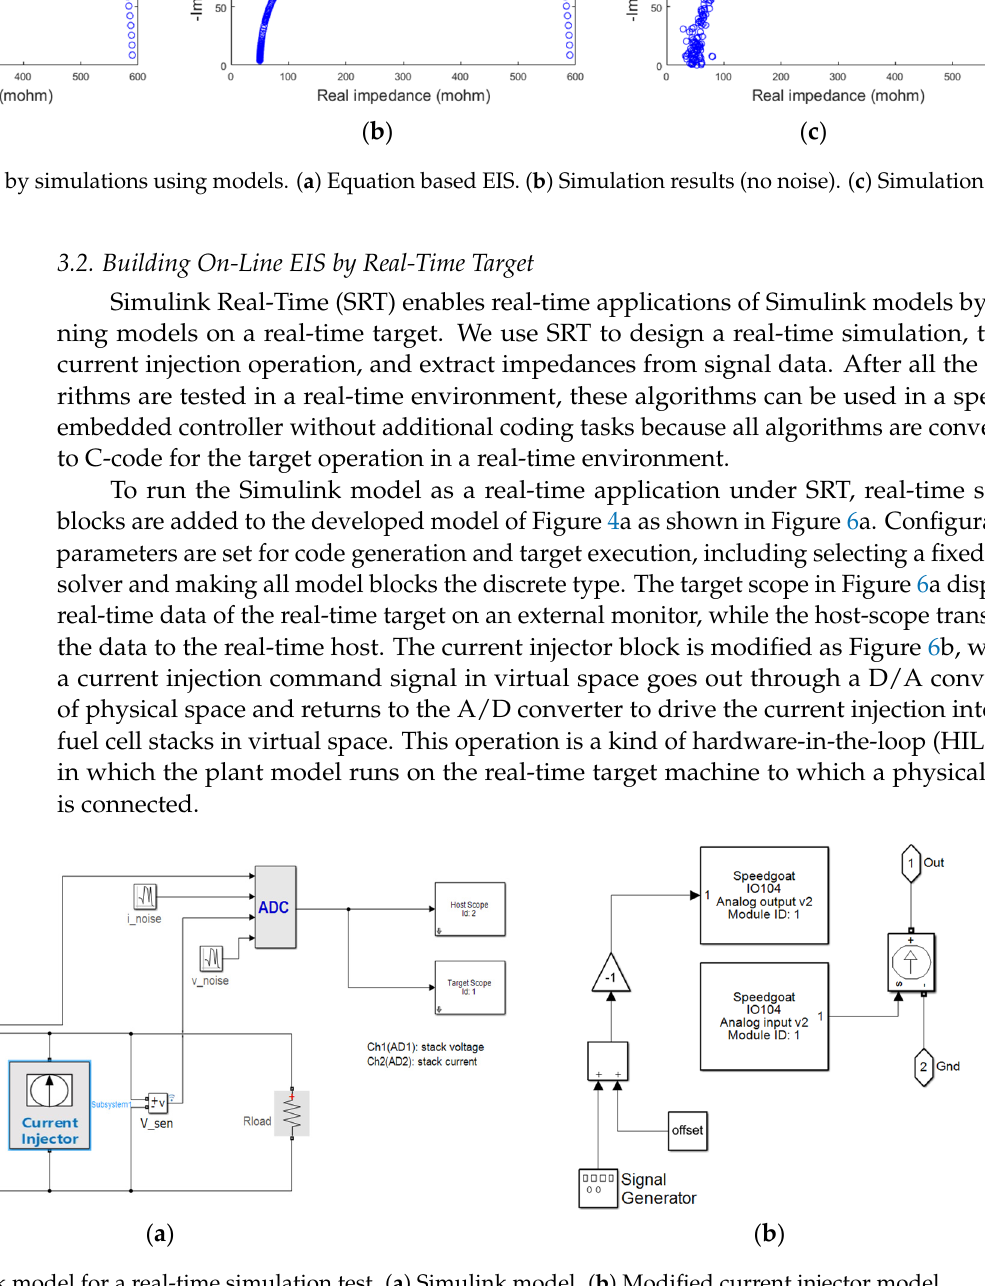
( b ) Figure 7. Real-time simulation of models in target machine and Nyquist plot. ( a ) Waveform of target scope. ( b ) Nyquist plot by real-time operation. During testing the validation of algorithms in the real-time target in the previous step, the algorithms run under a virtual space in which the fuel cell system is built as a real-time model. After confirming algorithms in this mode, we apply the real-time target machine to a real physical system, fuel cell power system, as shown in Figure 8. The real- time target controls the current injection device and measures the fuel cell voltage and current signal as described in Figure 3. All experiments in the next section are performed according to the configuration of Figure 8.